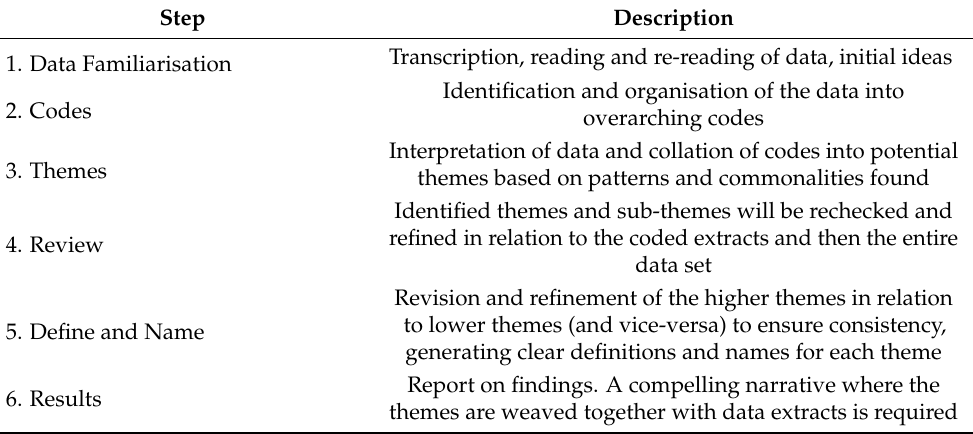
Table 2. Phases of thematic analysis in IPA (adapted from adapted from